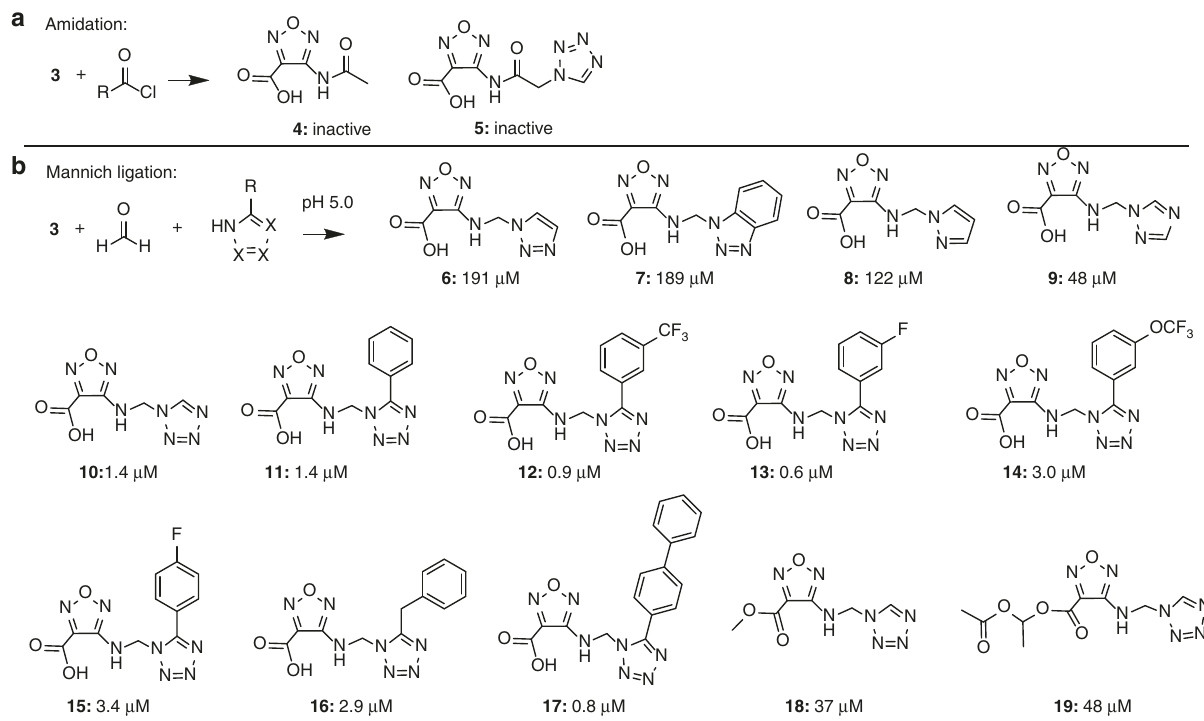
Fig. 2 Expansion of fragment 3 through protein-induced reactions. a Amidation of 3 yielded compounds 4 and 5 , which were inactive in the FP assay. b Mannich ligation was investigated as an alternative fragment expansion method to obtain the active compounds 6 – 19 containing a linker with reduced steric hindrance and better structural fl